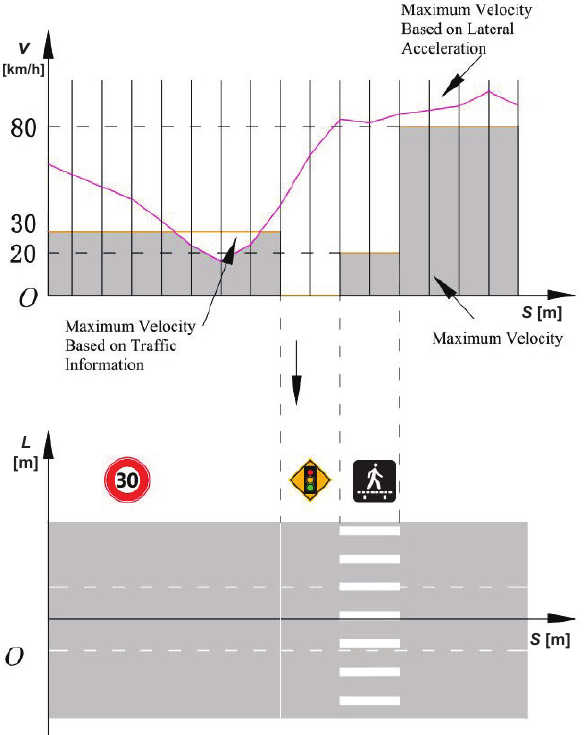
Figure 5. Maximum velocity considering traffic information and lateral